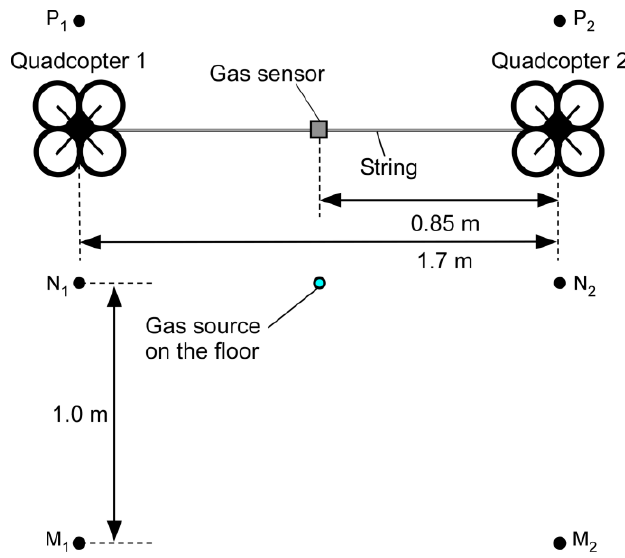
Figure 11. Setup of the flight experiment under no cross-flow conditions (top view). Quadcopter 1 was moved from point M 1 through point N 1 to point P 1 , while quadcopter 2 was moved from point M 2 through point N 2 to point P 2 .